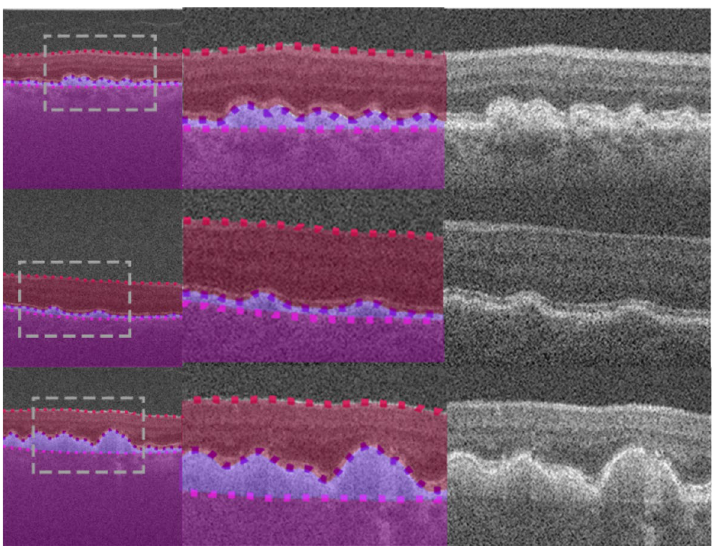
Figure 6. Example segmentation outputs from the R2 U-Net (3 layer variant) for the AMD dataset overlaid on the images. Left: full image with grey dashed rectangle corresponding to the zoomed area of the two rightmost images. Red region: retina (excluding BM), light purple region: BM, dark purple region: choroid + sclera. Dotted lines correspond to the boundary position ground truths.